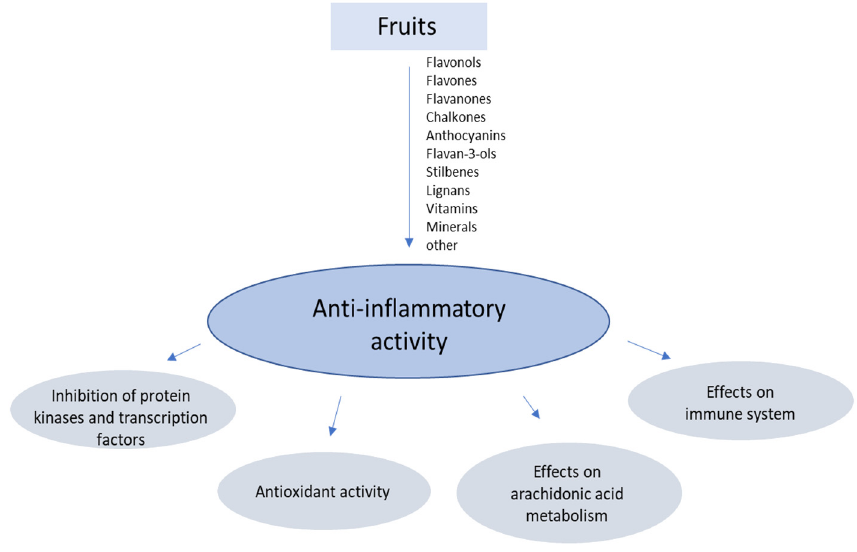
Figure 1. Selected targets of the anti-inflammatory activity of bioactive substances in fruits .